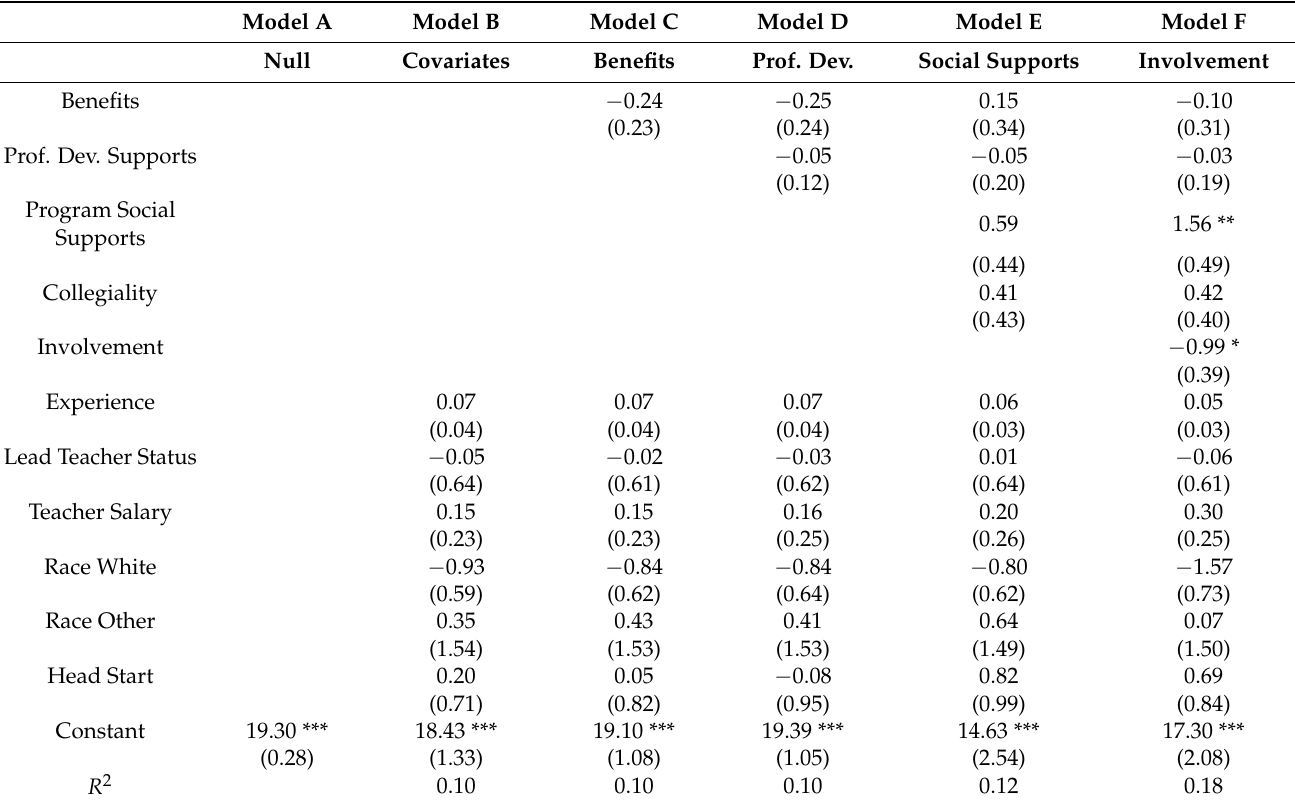
Table 4. Associations with teachers’ perception of support from